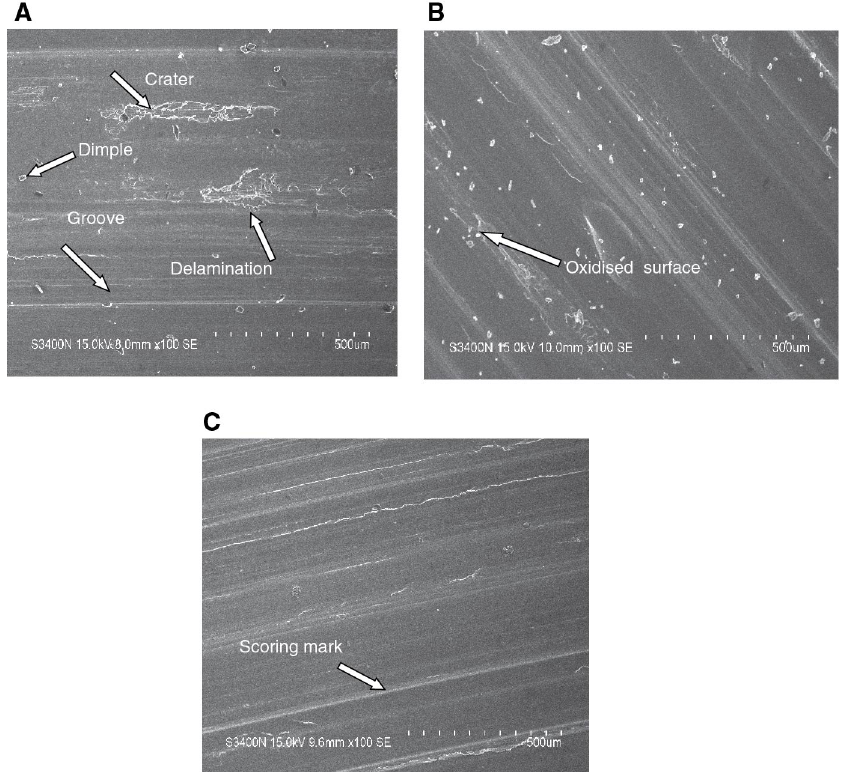
Figure 8: SEM images of worn surfaces of (A) as-cast alloy, (B) SD alloy and (C) SD+HC alloy at load of 10 N and sliding velocity of 1.5